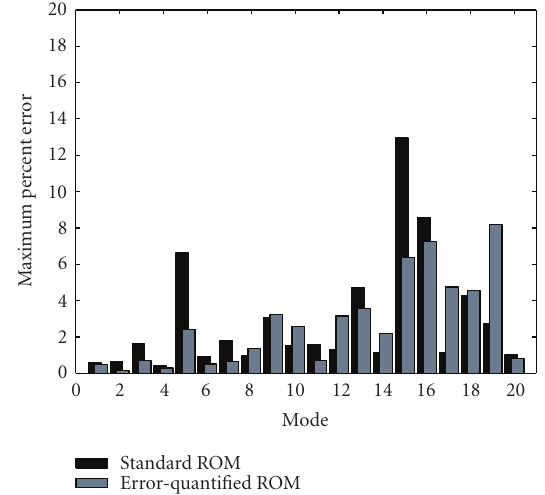
Figure 11: Maximum error calculation for airfoil modal force.